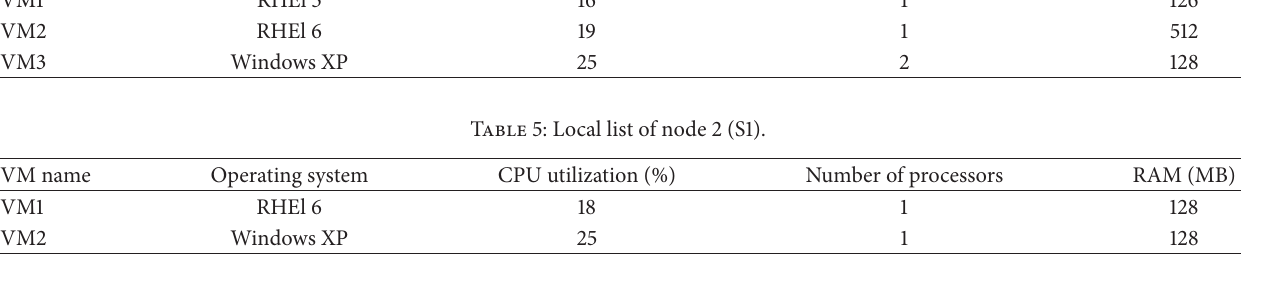
Table 6: Local list of node 3 (S1).